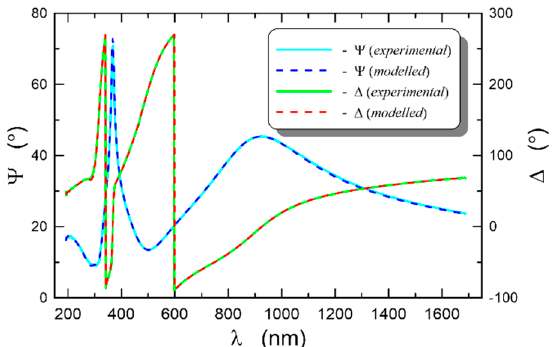
Figure 10. Dispersion characteristics of the ellipsometric angles for composite a SiO x :TiO y film on a